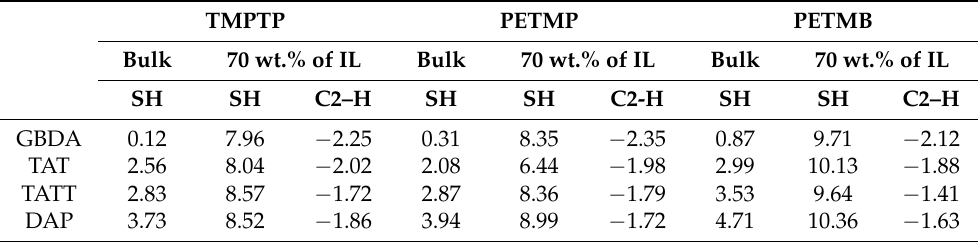
Table 1. Changes in the position of the absorption bands of the SH group of the thiol and C2–H of the imidazole ring of the ionic liquid in two- and three-component